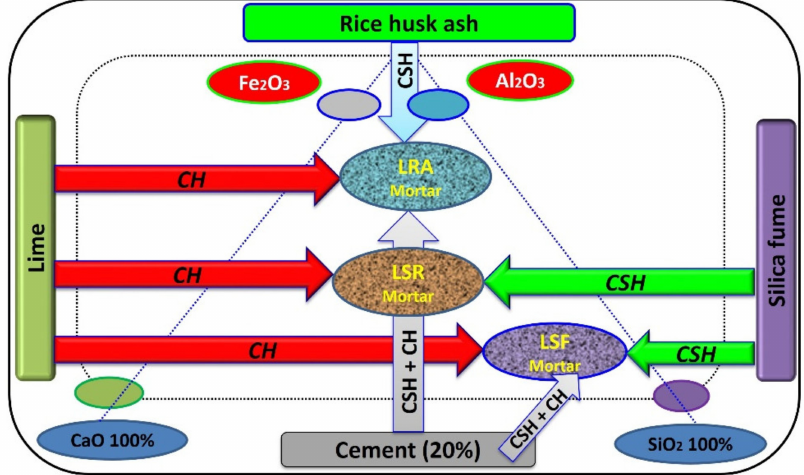
Figure 25. Mechanism of lime composite